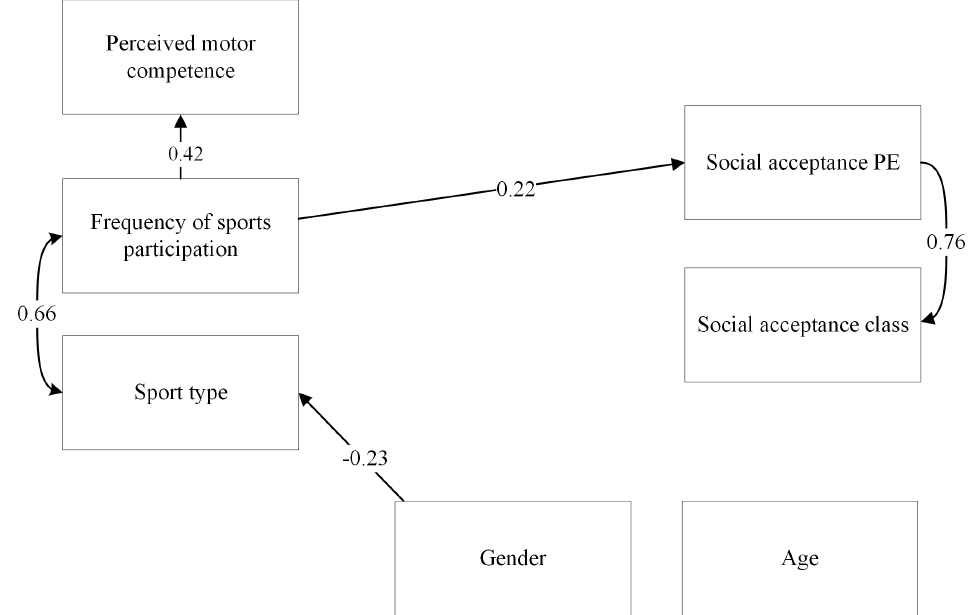
Figure 1. SEM model presenting significant paths between independent and dependent variables. Standardised path coefficients (betas) are presented in the figure.